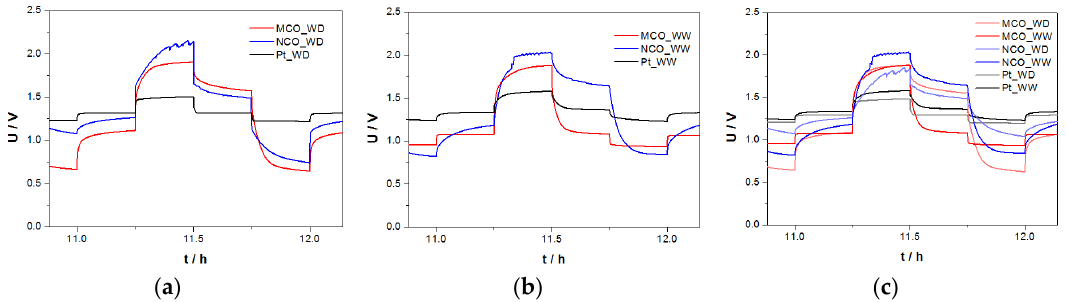
Figure 12. Comparison of 1-h charge/discharge profiles of different Zn/air cells at 100 µA cm − 2 during U/I test procedure in ( a ) 30 wt.% water-containing choline acetate electrolyte—dry air (WD) and ( b ) 30 wt.% water-containing choline acetate electrolyte—ambient air feed (30% RH at 23°C) (WW). ( c ) Overlay of Figure 12a,b.